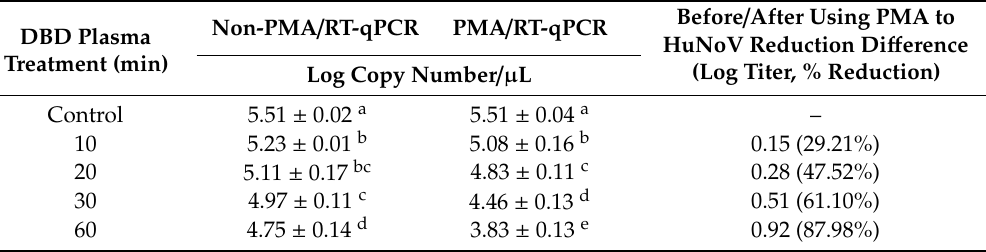
Before / After Using PMA